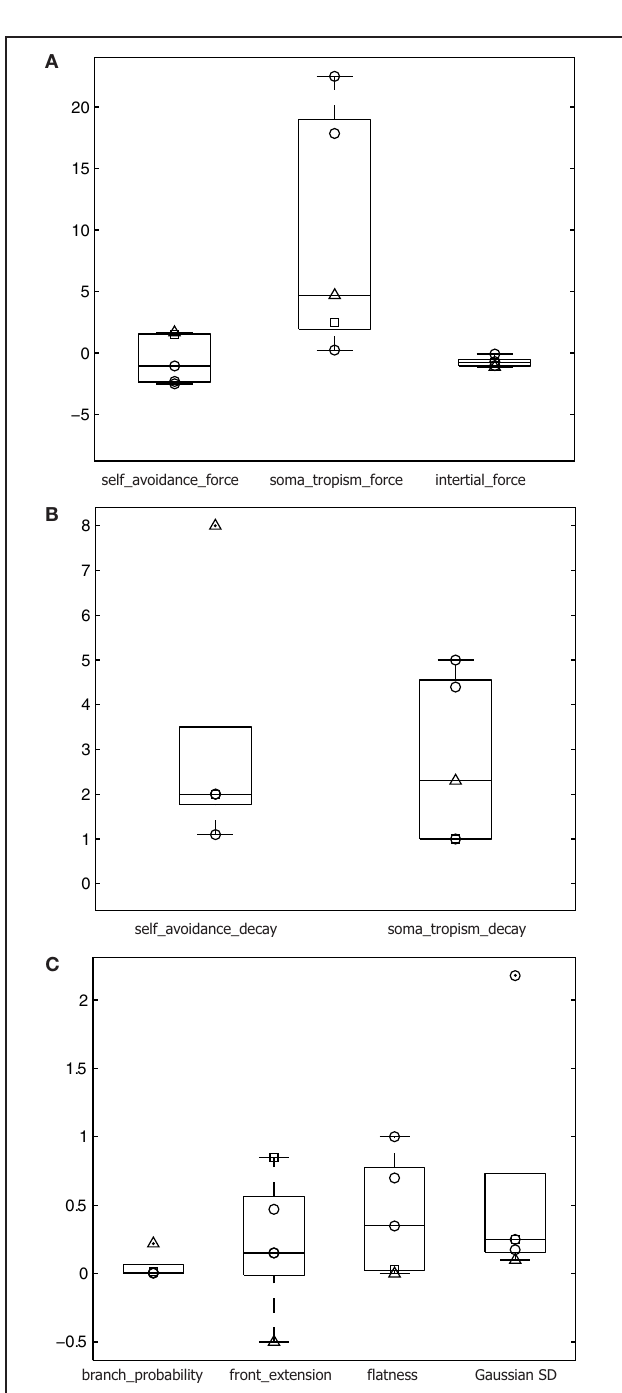
FIGURE 7 | Parameters differing across cell types. (A) Force parameters plotted on logarithmic scale y -axis for the three cell types: alpha motor neurons ( (cid:8) ), granule cells ( (cid:2) ), and Purkinje cells ( (cid:9) ). All parameters plotted and superimposed on box plots, with median indicated by a horizontal line, the box’s edges indicating the 25th and 75th percentiles, the whiskers extending to all points not considered outliers, and outliers ( > 1.5 × the box height beyond the box edge) marked by a dot. (B) Spatial gradient parameters for the three cell types plotted on a linear scale y -axis. (C) Additional relevant parameters for the three cell types plotted on a linear scale y